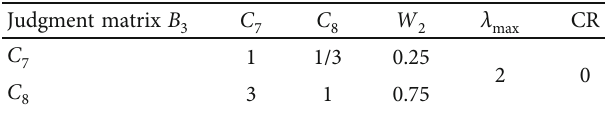
Table 15: Judgment matrix of organizational management